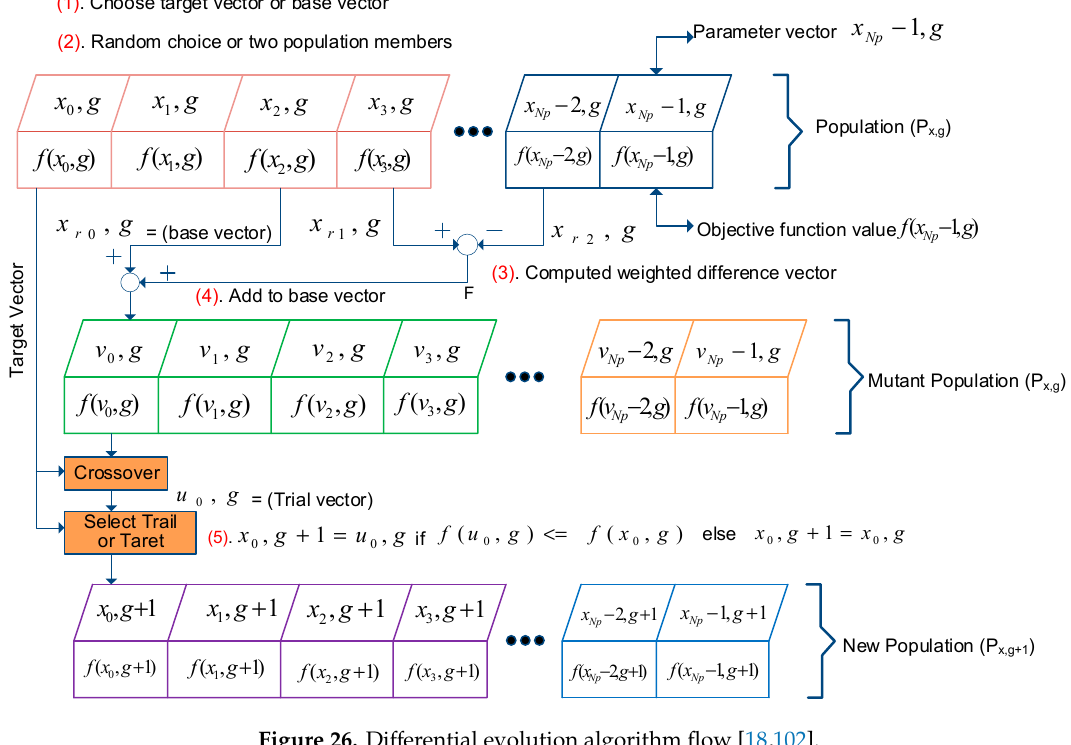
Figure 26. Differential evolution algorithm flow [18 , 102]. Figure 26. Di ff erential evolution algorithm flow